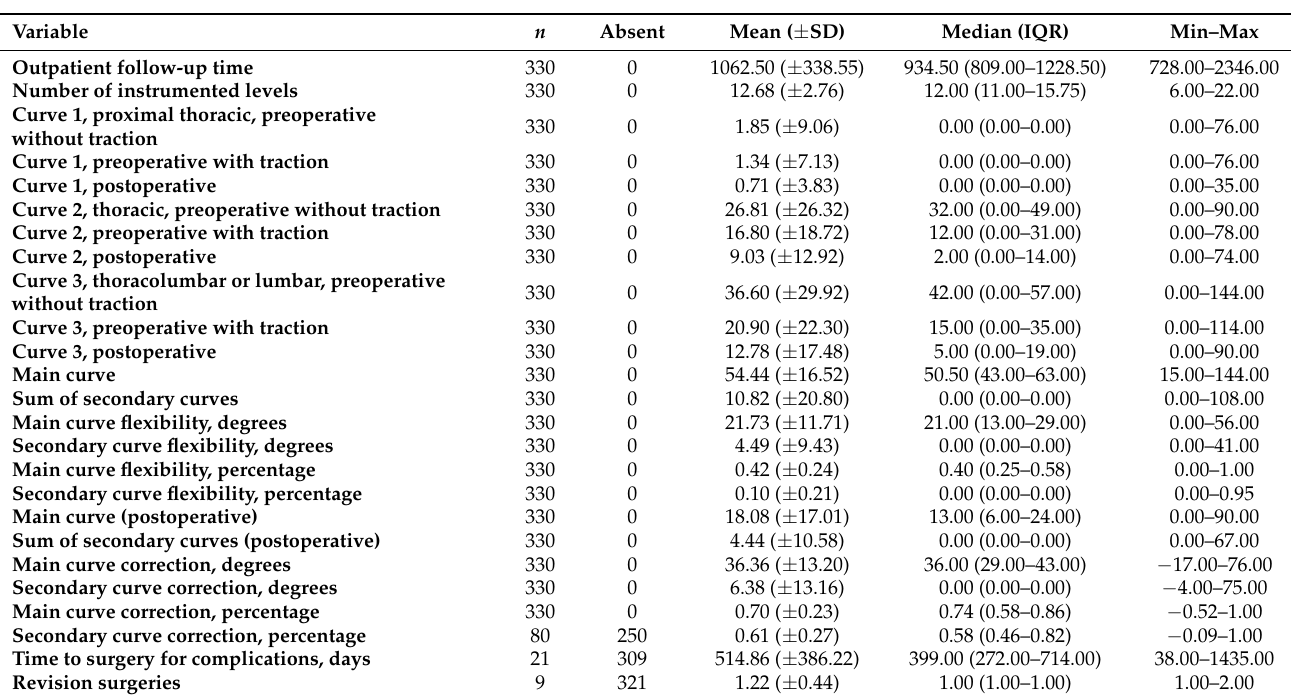
Table 2. Descriptive statistics of quantitative variables.